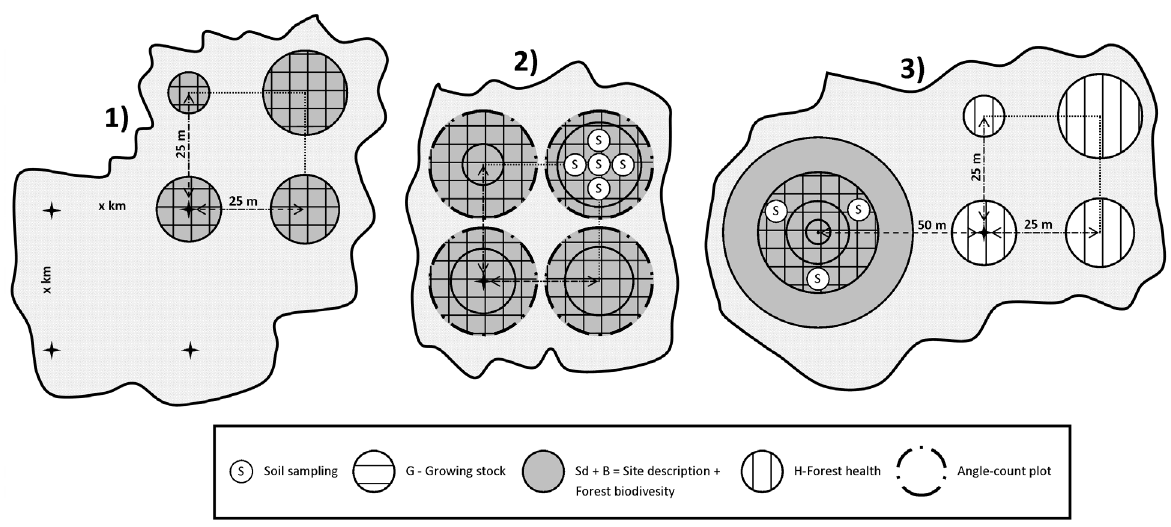
Figure 2. Historical development of Slovenia’s integrated forest resource inventory. 1) 1987–1994: National Forest Health Inventory. The inventorying was performed in clusters, consisting of four 6-tree plots. 2) 1995: Integrated Forest Resource Inventory (IFRI). Forest soil sampling and the assessment of growing stock became part of inventorying. To achieve good estimates on growing stock, angle-count plots (superimposed over 6- tree plots) were introduced. 3) 2000 onwards: Integrated Forest Resource Inventory. Introduction of invisible concentric permanent sample plots with fixed areas. The plots have been used for collecting data and information on forest sites, growing stock and increment, forest health, biodiversity, ecosystem services, average tree cut (harvest). Forest health has been assessed on 6-tree plots and on concentric permanent sample plots.